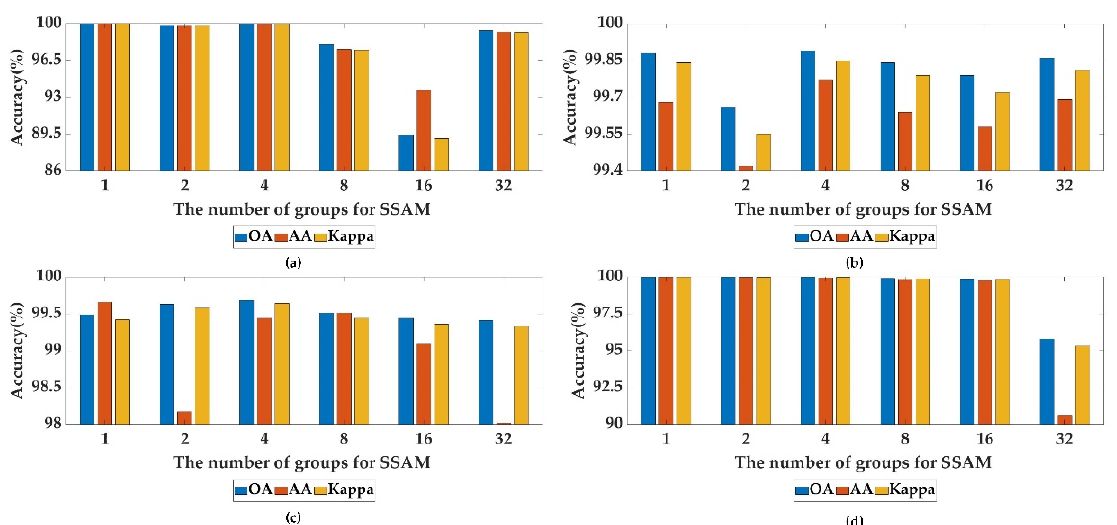
Figure 13. The classification results of different number of groups for SSAM. ( a ) on the SAC dataset, ( b ) on the UP dataset, ( c ) on the IP dataset, ( d ) on the SA dataset.